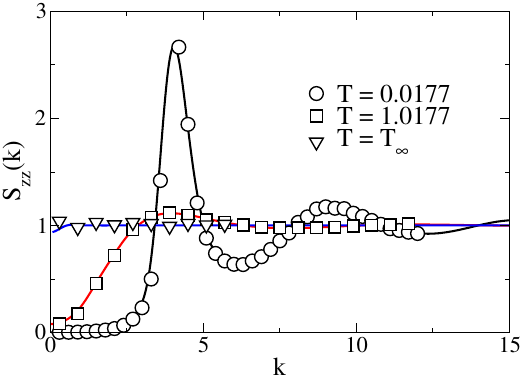
Figure 2: Charge-Charge structure for the molten salt model. Symbols are data obtained from Eq. (24) and full lines are from Eq. (25)